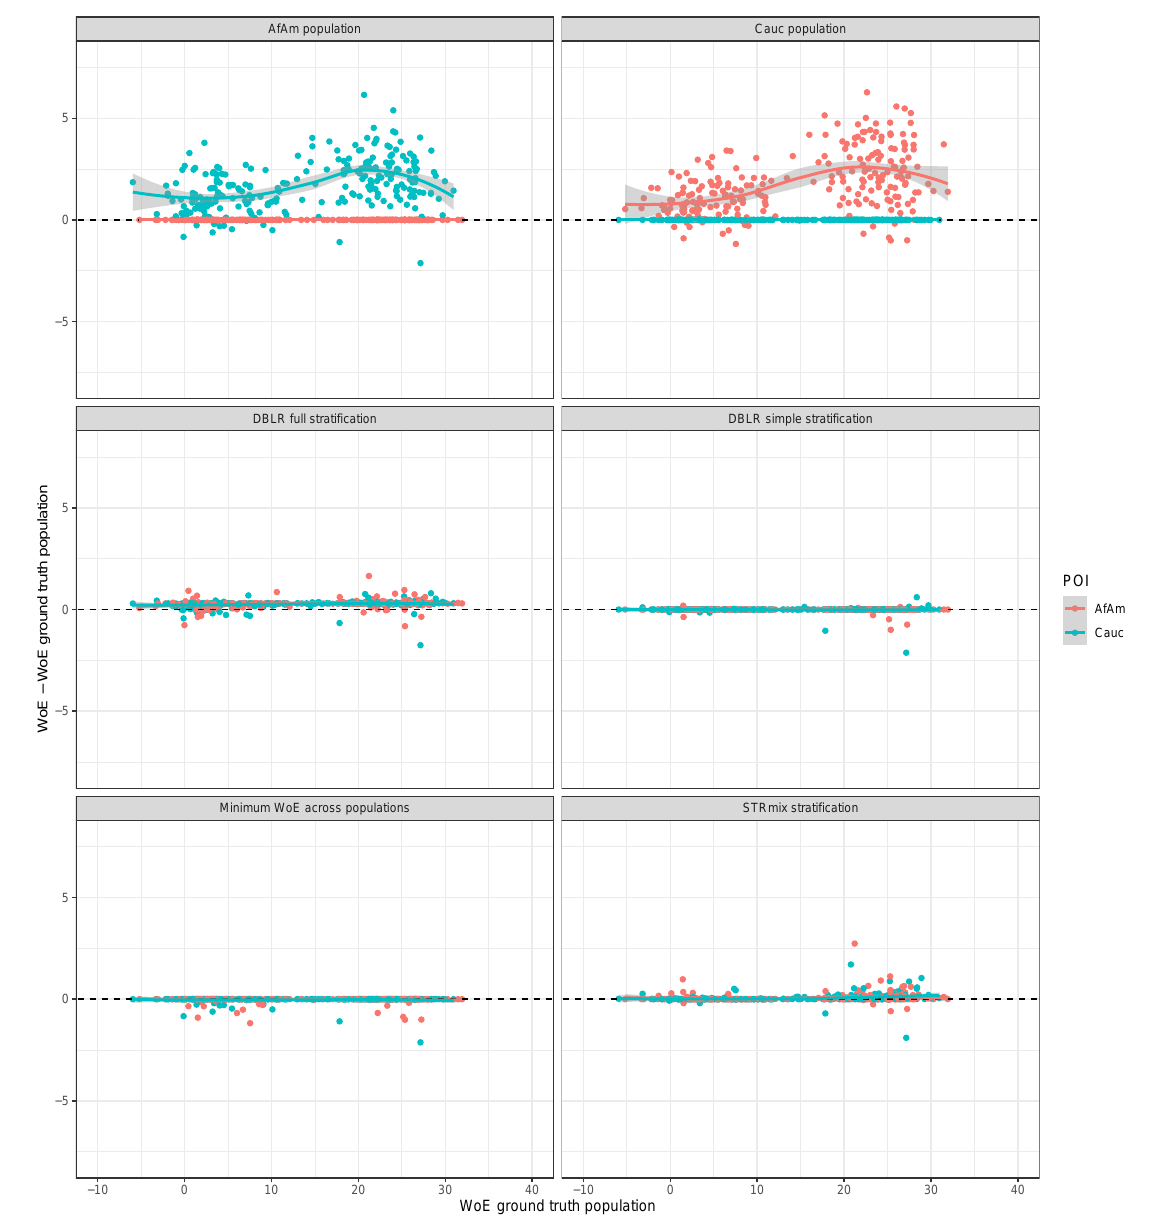
Figure 4. WoE difference between the compared methods and the WoE evaluated using the ground truth population with F ST = 0.01 for the 500 donors to 250 simulated two-person mixtures with contributors from the same